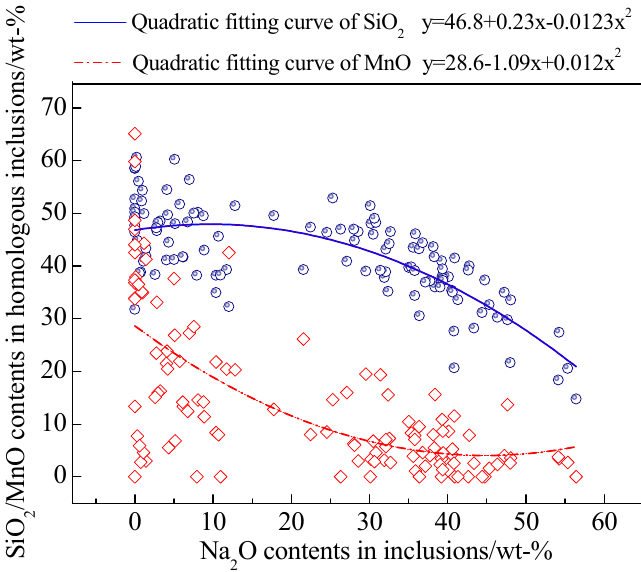
Figure 15. Compositional changes with Na 2 O content in inclusions from Heat D.